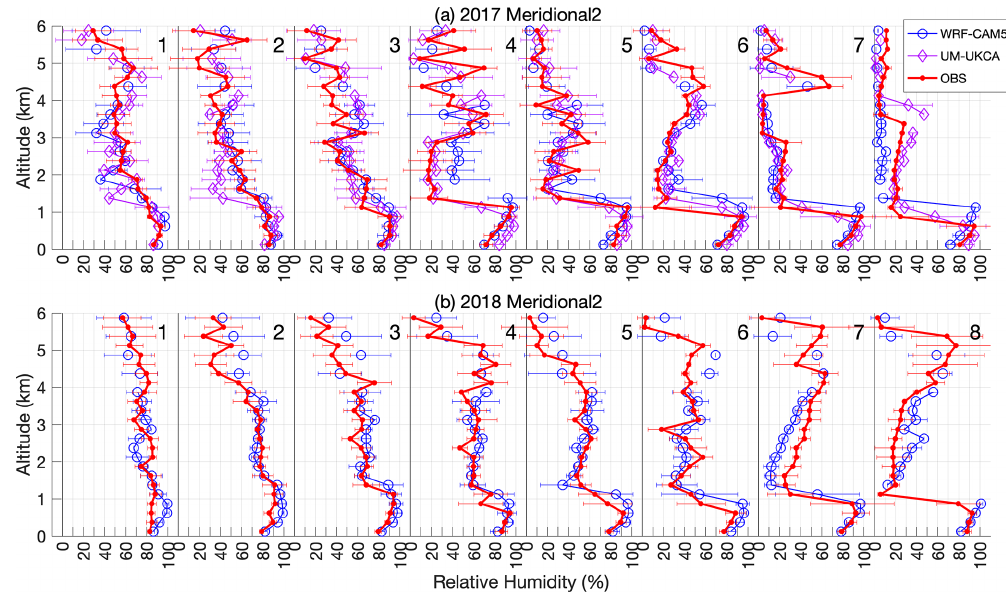
Figure 11. As in Fig. 10 but for RH along the (a) 2017 and (b) 2018 meridional 2 transect.